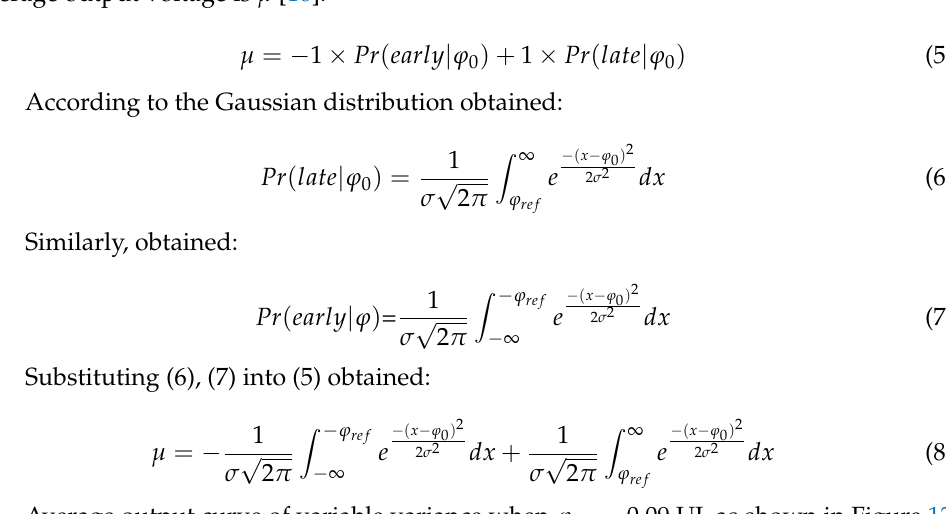
Figure 12. Relationship between clock sampling phase and PD output voltage. Due to the presence of jitter, the output voltage varies with the phase difference between clock and data. The output voltage can replace by the average value of the output voltage. Such a jitter generally includes Gaussian jitter, uniform jitter, and sinusoidal jitter. When the jitter is Gaussian with mean ϕ 0 and variance σ , the average output voltage is represented by µ . The early probability is Pr ( early | ϕ 0 ) , and the late probability is Pr ( late | ϕ 0 ) . When the average value of the phase difference is ϕ 0 , the expression of